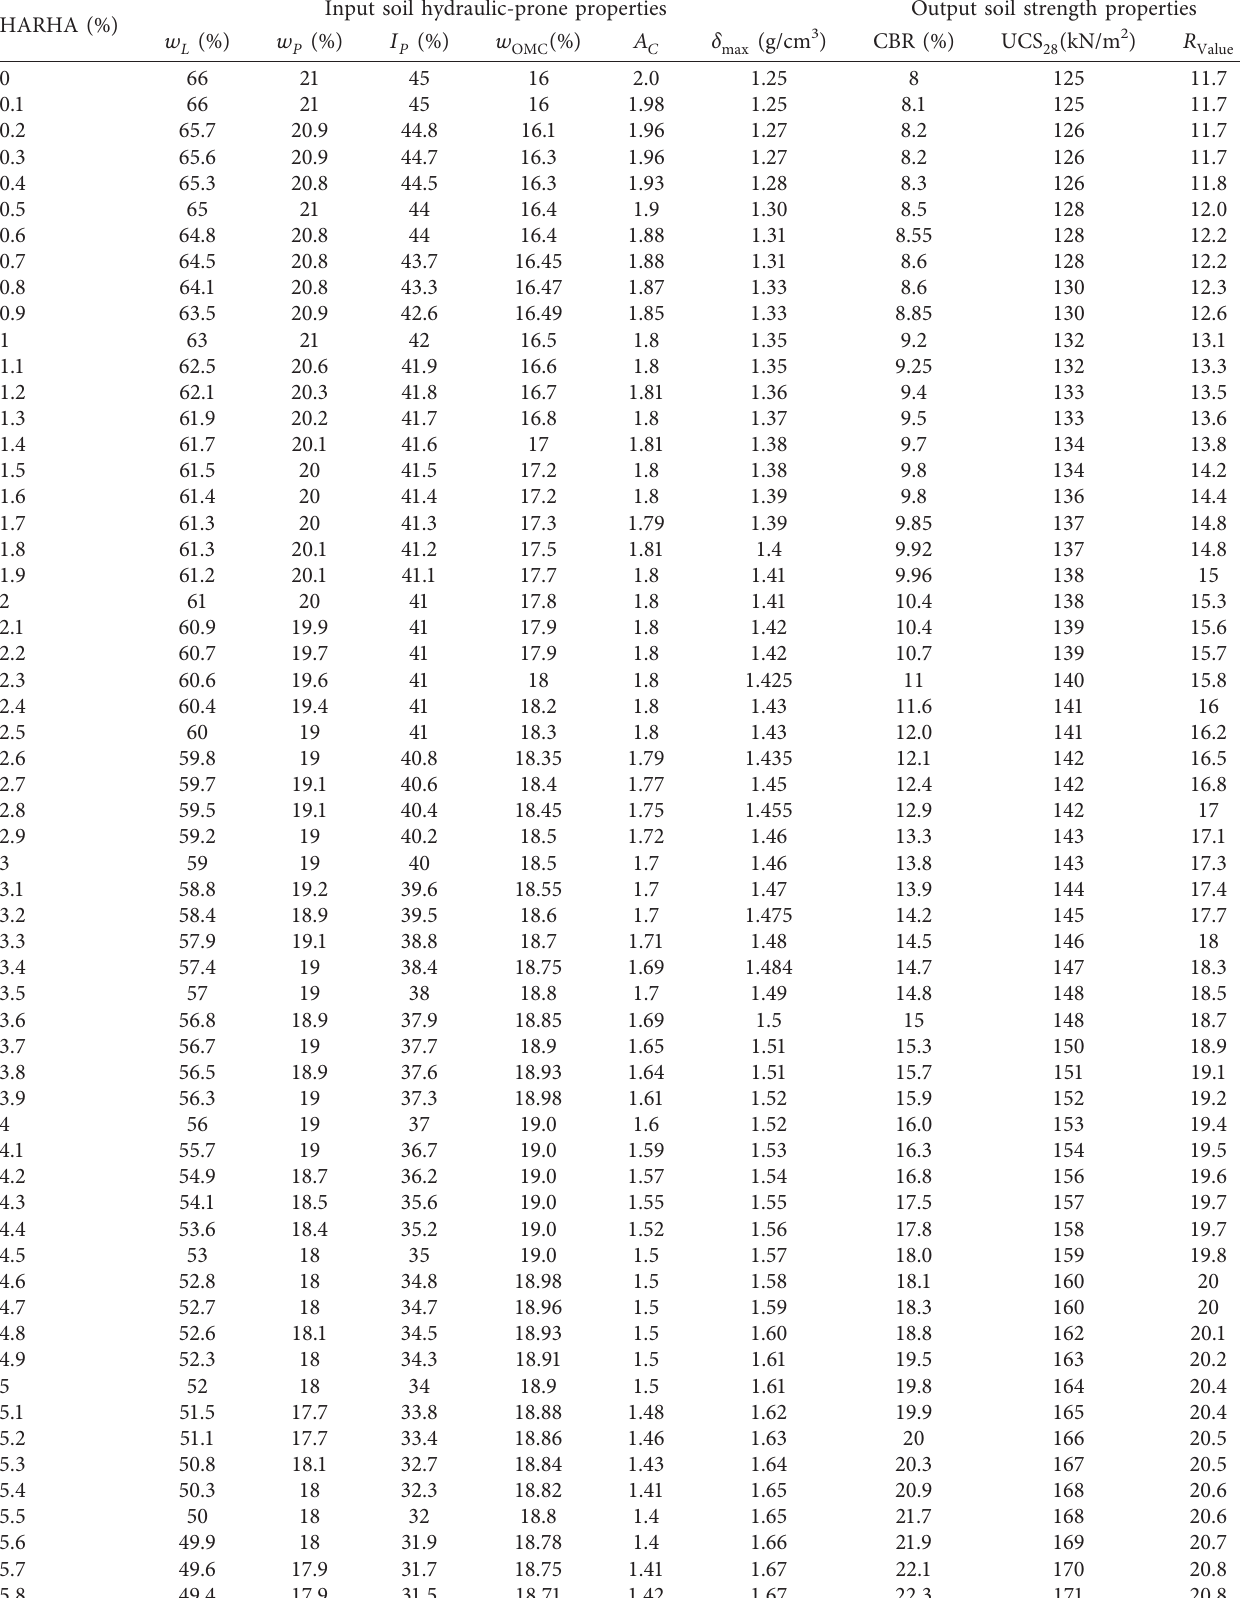
Table 1: 121 datasets of input and output